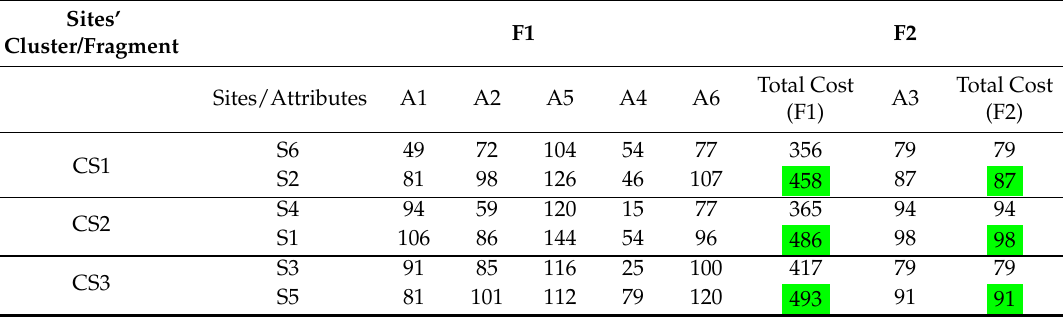
Table 22. Fragment allocation over sites (Scenario 3) of this